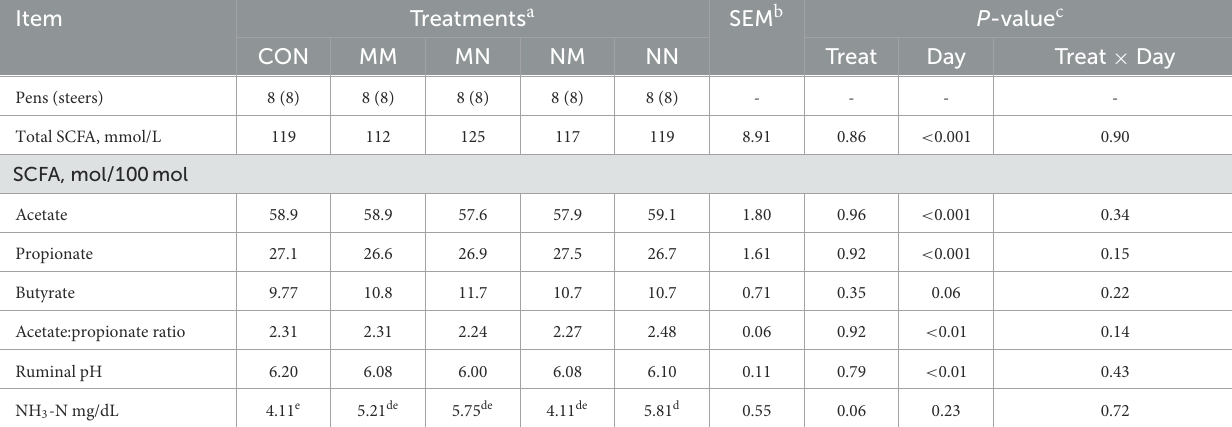
TABLE 4 Effect of feed additives on the ruminal concentration of short-chain fatty acids (SCFAs), pH, and ammonia nitrogen (NH 3 -N) of finishing beef cattle—Exp.